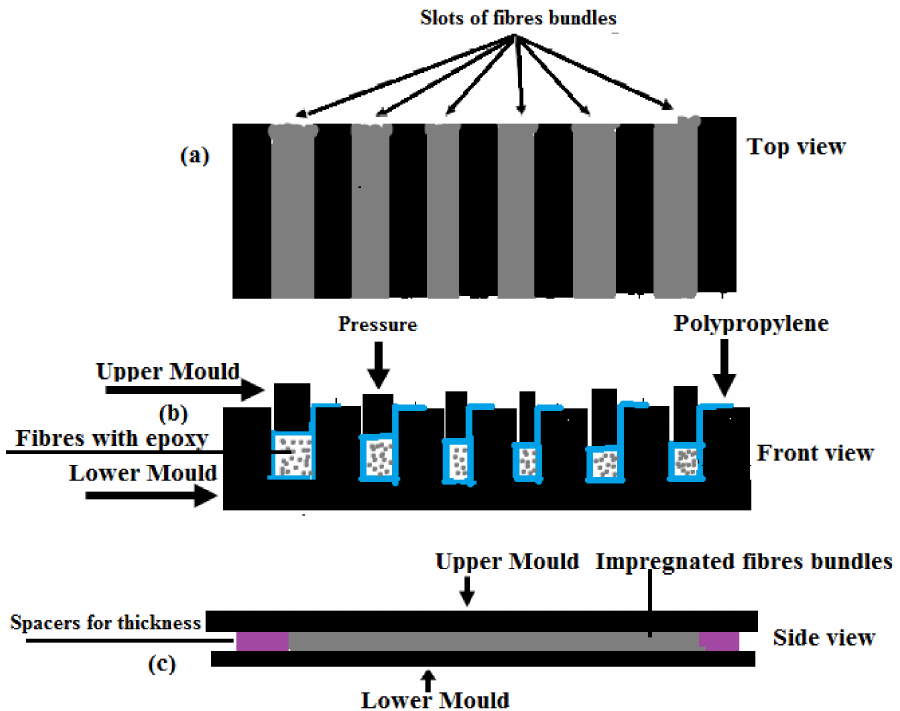
Figure 2. Testing of impregnated fibre bundles: ( a ) six mould cavities from the top view; ( b ) a front view of the mould’s cavities (spacer not placed, with the vacuum film surroundings all the bamboo fibre bundle); and ( c ) the counter-mould in the longitudinal cross-section with the